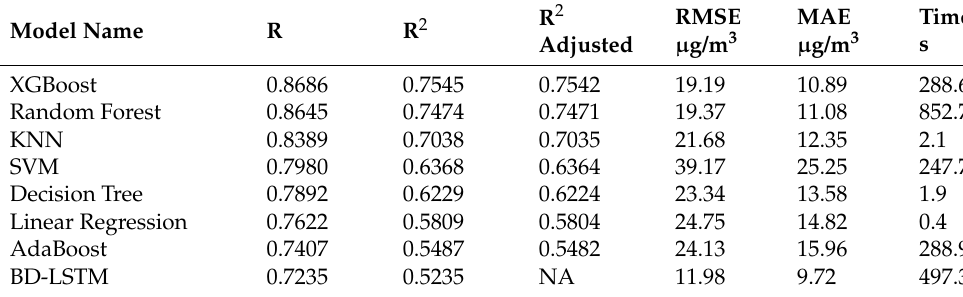
Table 7. Winter cross-validation results (January,